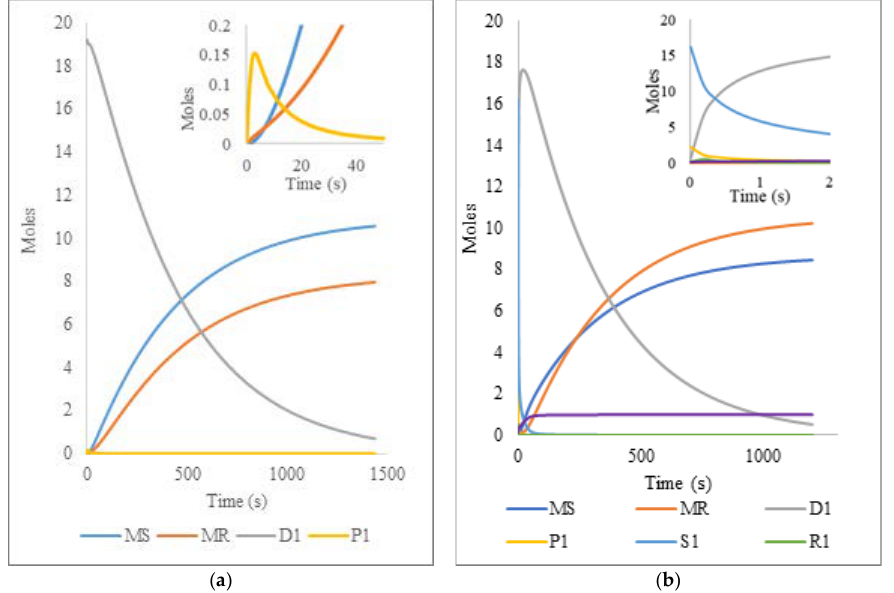
Figure 5. Variation of the species MS (monomer styrene), MR (monomeric radical), D1 (first moment, dead oligomer), P1 (first moment, living oligomer), S1 (first moment, dormant oligomer), R (first moment, living oligomer with nitroxide) and NX (nitroxide radicals) in the pyrolysis of ( a ) Free Radical Oligomer and ( b ) Nitroxide Mediated Oligomer.